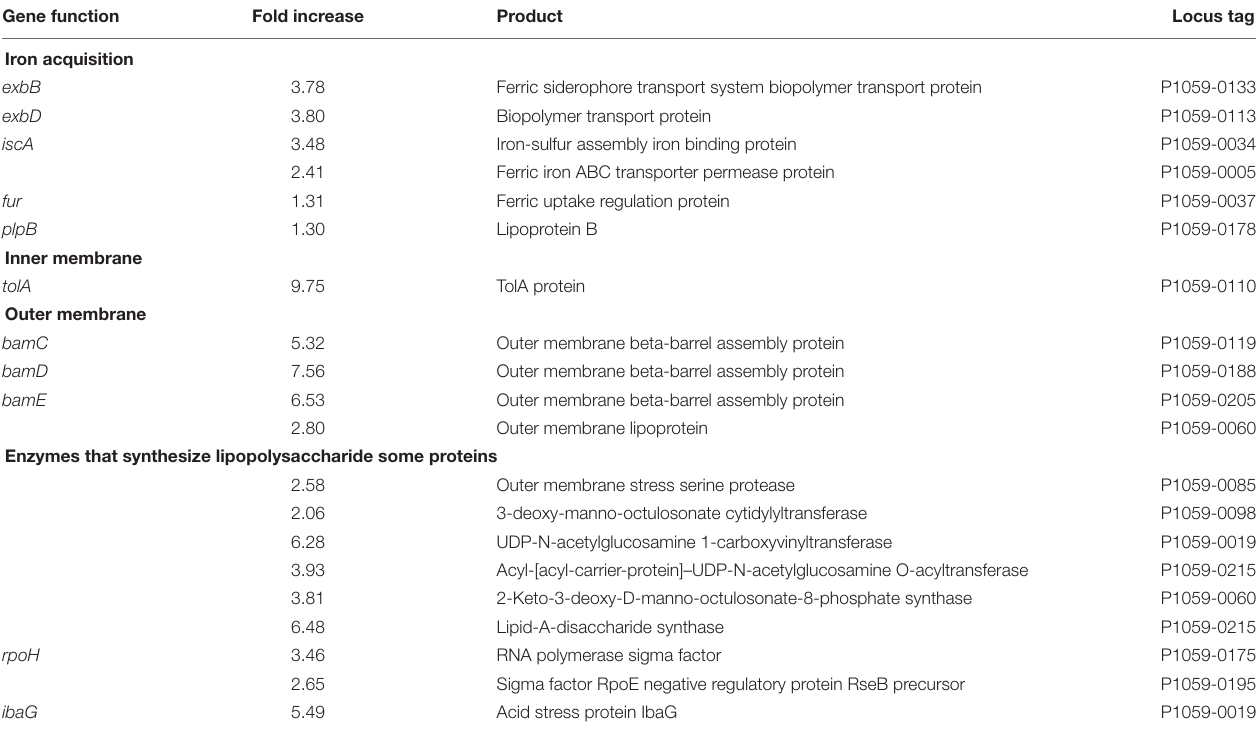
TABLE 3 | Examples of genes significantly differentially regulated when P. multocida was grown in a poly-microbial biofilm with H. somni compared to a monophasic biofilm.